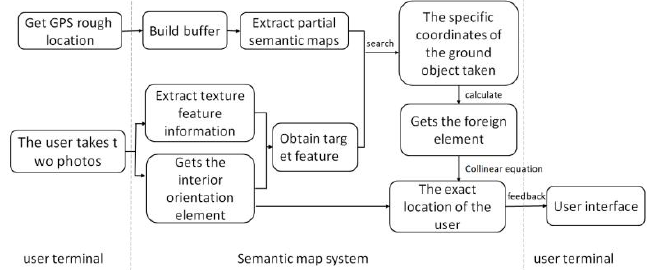
Figure 2 The Flowchart of The Intelligent Identification